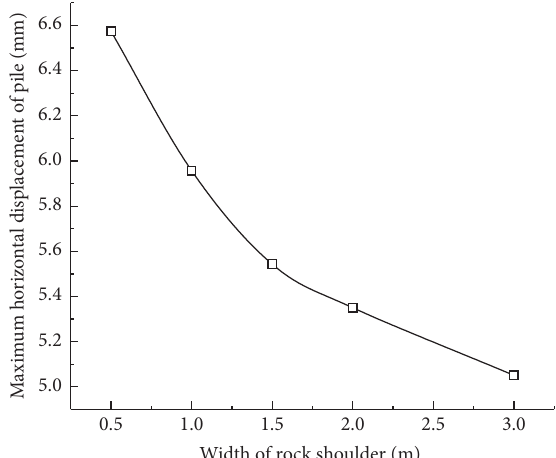
Figure 14: Influence of shoulder width on horizontal displacement of the